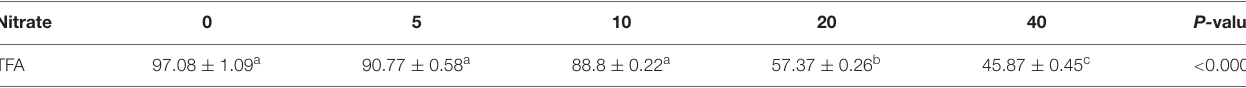
Values are mean ± SD, significant differences (P < 0.05) each row are indicated by different lower-case letters. TFA, total fatty acids. TABLE 3 | Fatty acid compositions (% total fatty acids) of P. damicornis larvae with different nitrate concentrations. Nitrate